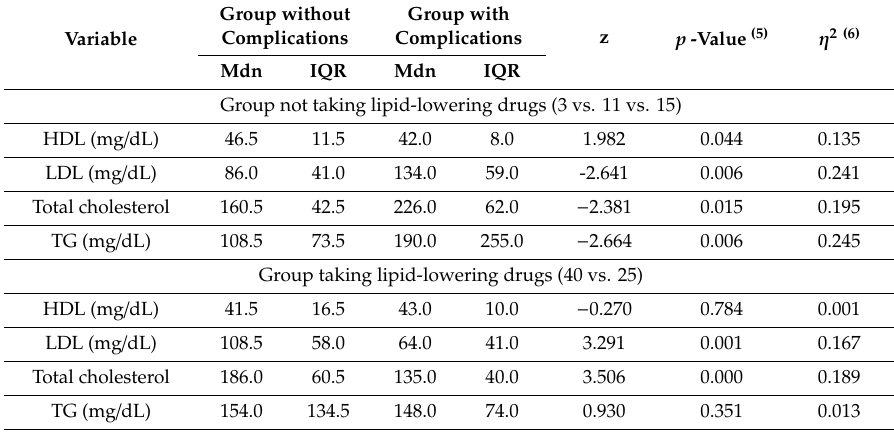
Table 4. Classification of lipidogram parameters in patients with type 2 diabetes due to cardiovascular complications. Frequency analysis of quantitative variables. Parametric analysis with the U Mann– Whitney